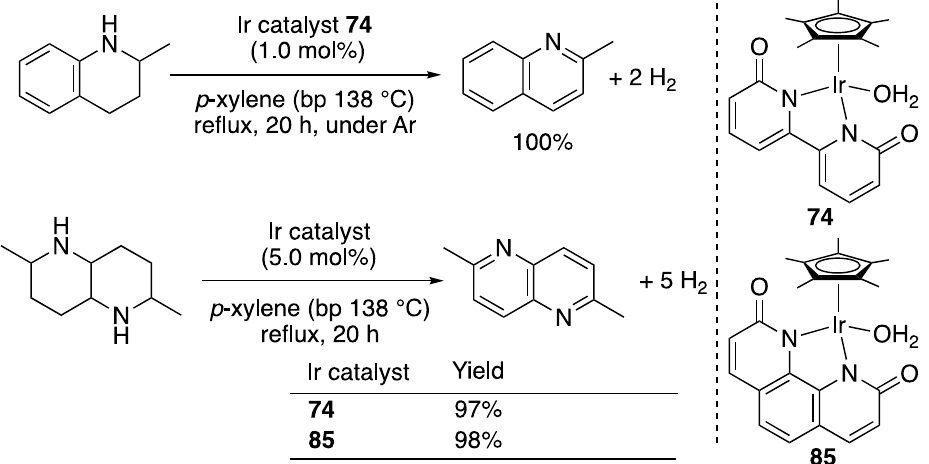
Scheme 77. Catalytic dehydrogenation of 2-methyl-1,2,3,4-tetrahydroquinoline and